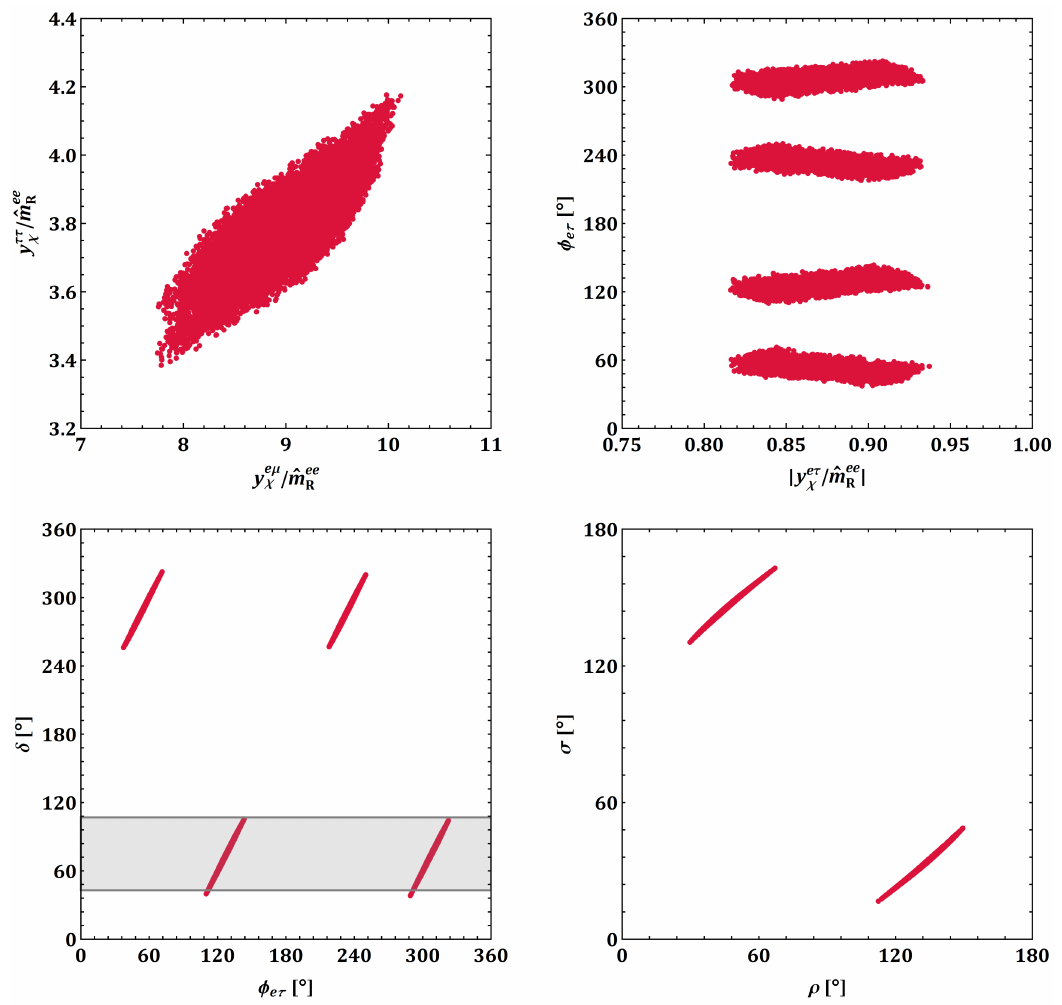
/ m ee | , / m ee , y ττ / m ee , | y eτ b b b χ χ χ R R R